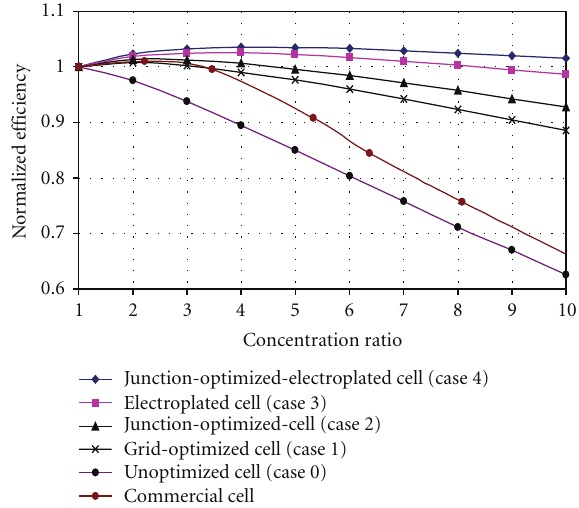
Figure 7: Normalized e ffi ciency plot of cell designs for the junction- optimized-electroplated cell, electroplated cell, grid-optimized cell, and unoptimized and commercial 1sun